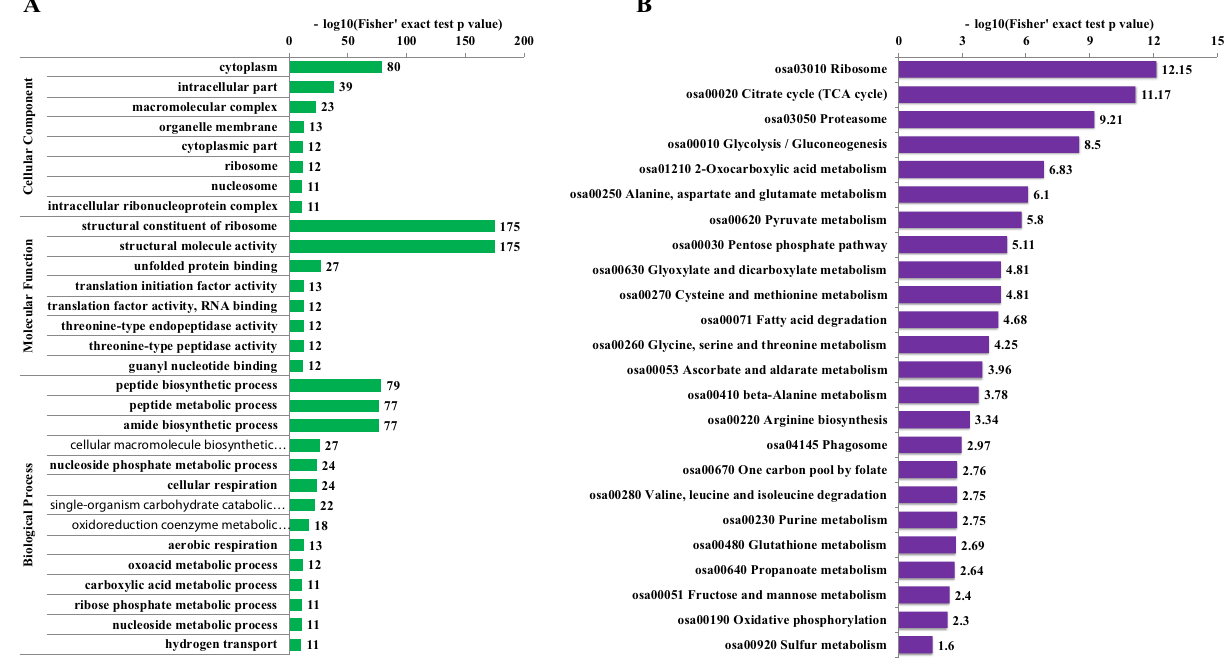
Figure 3. Enrichment analyses of the Khib proteins. ( A ) GO annotation based enrichment analysis. ( B ) KEGG pathway based enrichment